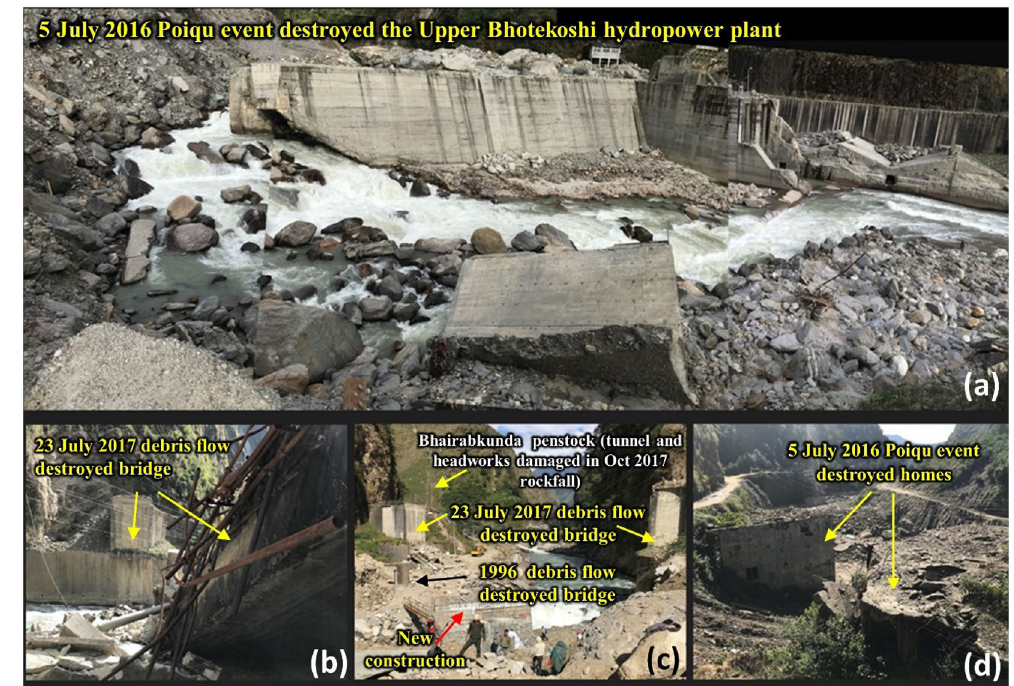
Figure 10. Field photographs of ( a ) the destroyed 45 MW Upper Bhotekoshi hydropower station and nearby infrastructure by the 2016 Gongbatongsha GLOF event (photographed 11/2017). The large boulders (up to 8 m diameter) above and behind the dam were emplaced by the GLOF/debris flow. Power transmission lines were damaged during the 2014 Jure landslide. Multiple key components of the power project were severely